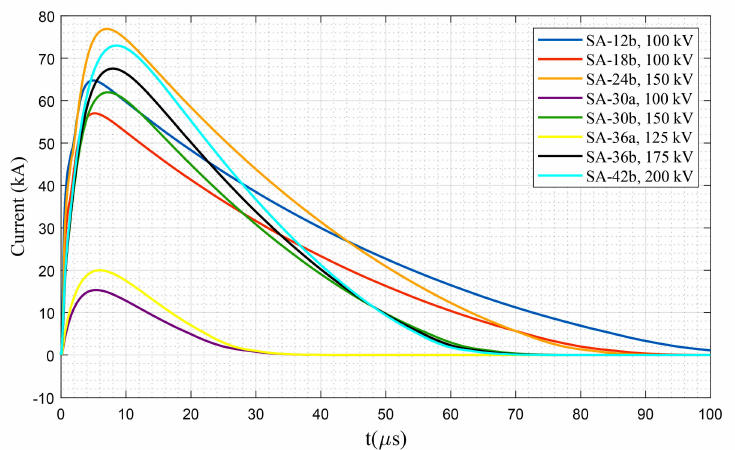
Figure 16. Current flow through surge arresters under their highest handleable overvoltage impulse, Case